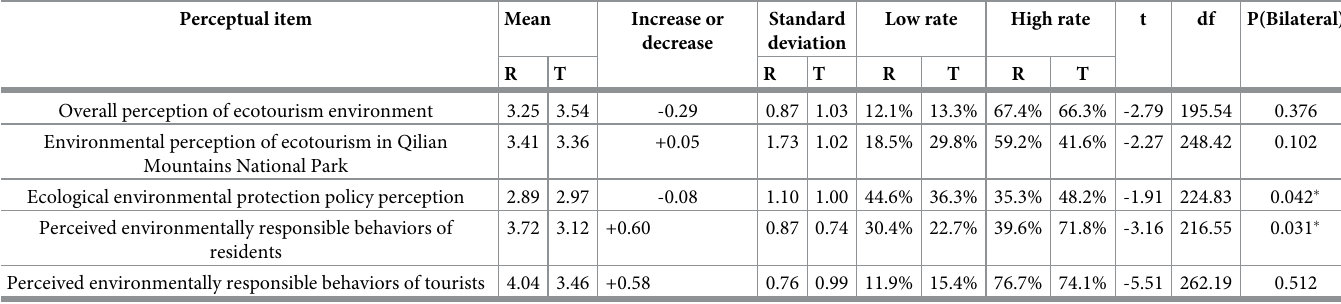
Table 17. Contrastive dimensional analysis of perceived ecotourism environmental responsibility by residents and